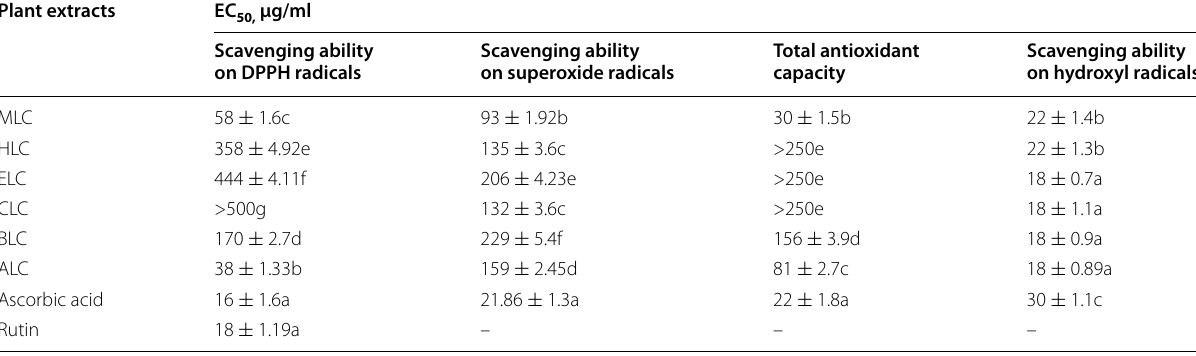
Table 1 Antioxidant effect (EC ) on DPPH radicals, superoxide radicals, total antioxidant capacity and hydroxyl radicals 50 of methanol extract and soluble fractions of C. opaca